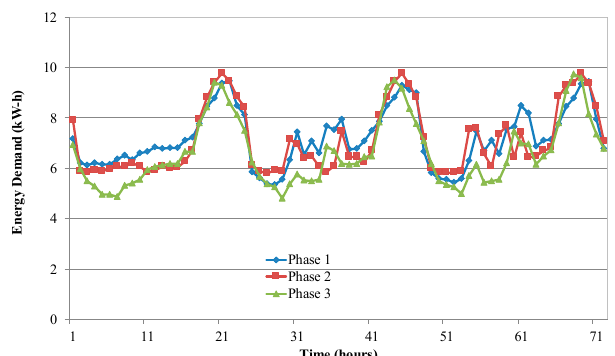
Figure 5. Demand curves for the example in Figure 3 after load balance employing the